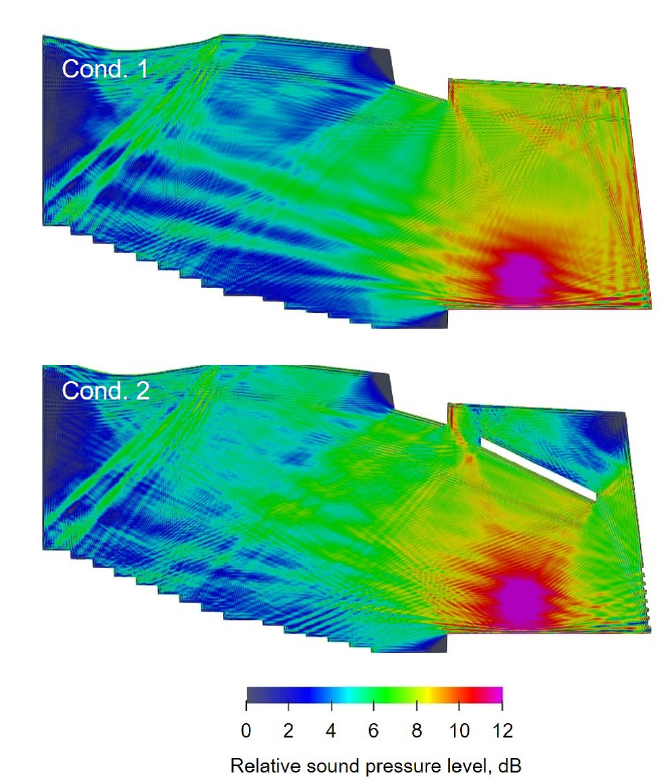
Figure 17. Comparison of time-integrated sound pressure level until 0.1 s for Cond. 1 (upper) and Cond. 2